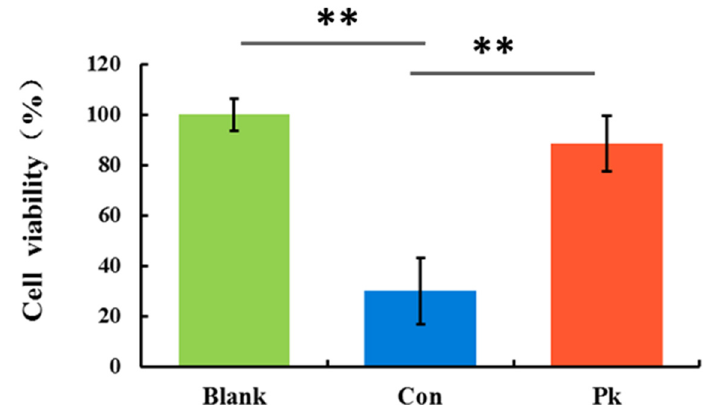
Figure A1. Effects of 5-FU on the viability of Caco-2 cells on chip with different drug administration regimens. Caco-2 cells were exposed to 5-FU (20 μ g/mL) for 2 days under Blank, Con, and Pk groups, respectively. Quantitative analysis of cell viability in Caco-2 cells after treatment with 5-FU (20 μ g/mL) for 2 days using CCK-8 kit. N = 3, * P < 0.05, ** P < 0.01.